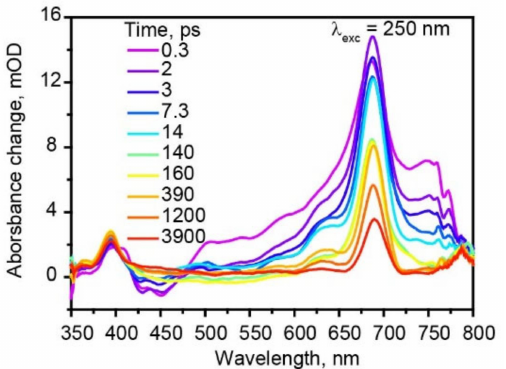
Figure 5. Femtosecond transient absorption spectra of hexaphenyl film at λ exc = 250 nm.